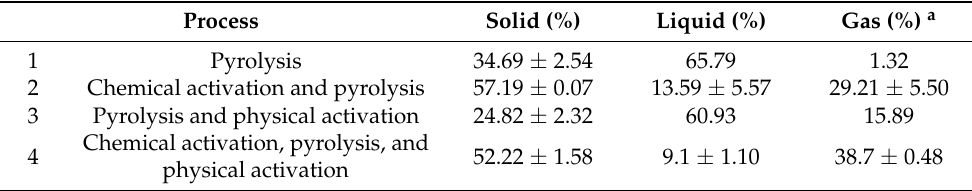
Table 2. Solid, gas, and liquid yields of each pyrolysis process expressed as a percentage of the weight of the sample fed into the pyrolysis reactor. Note: Average and standard deviation were calculated considering only experimentally reliable values.